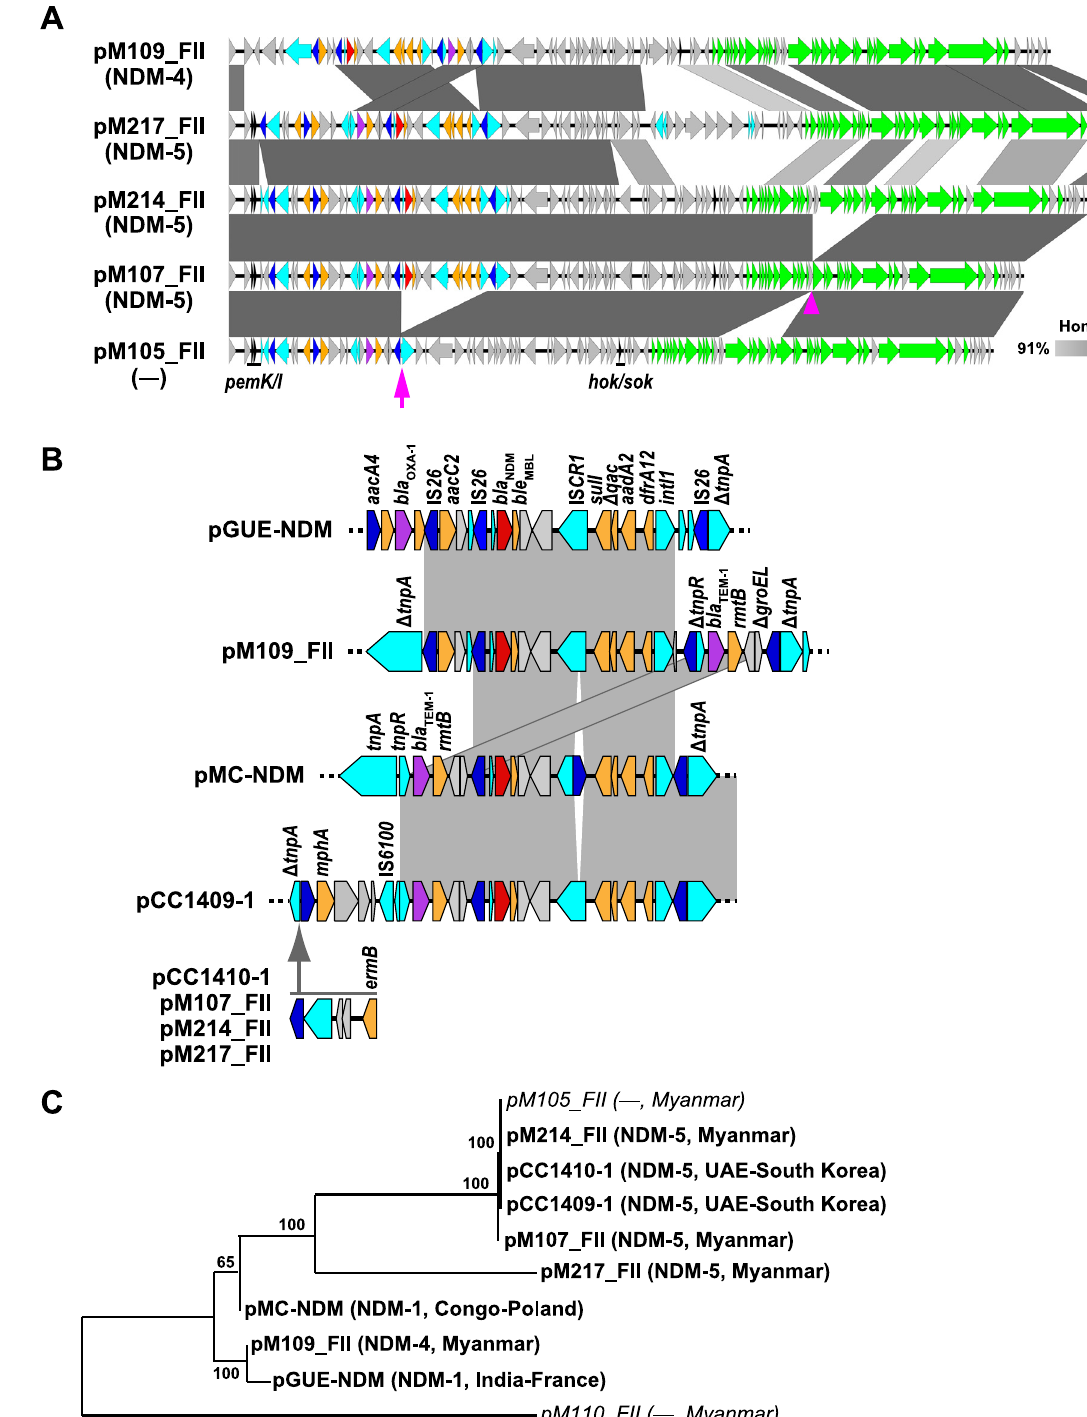
Fig 4. IncFII plasmids harboring bla NDM . (A) Comparison of IncFII plasmidsharboring bla NDM in Myanmar isolates. Homologous regions are shadedgray, with the percent identity shaded accordingto the color bar. The arrowheadindicatesa deletion in pM107_FII that encompasses severalgenesinvolvedin conjugal transfer. The arrow indicatesa deletionof a gene cluster carrying bla NDM-5 in pM105_FII. Genes are indicatedin colors as definedin Fig 2, except that genes involvedin conjugaltransfer and toxin-antitoxin